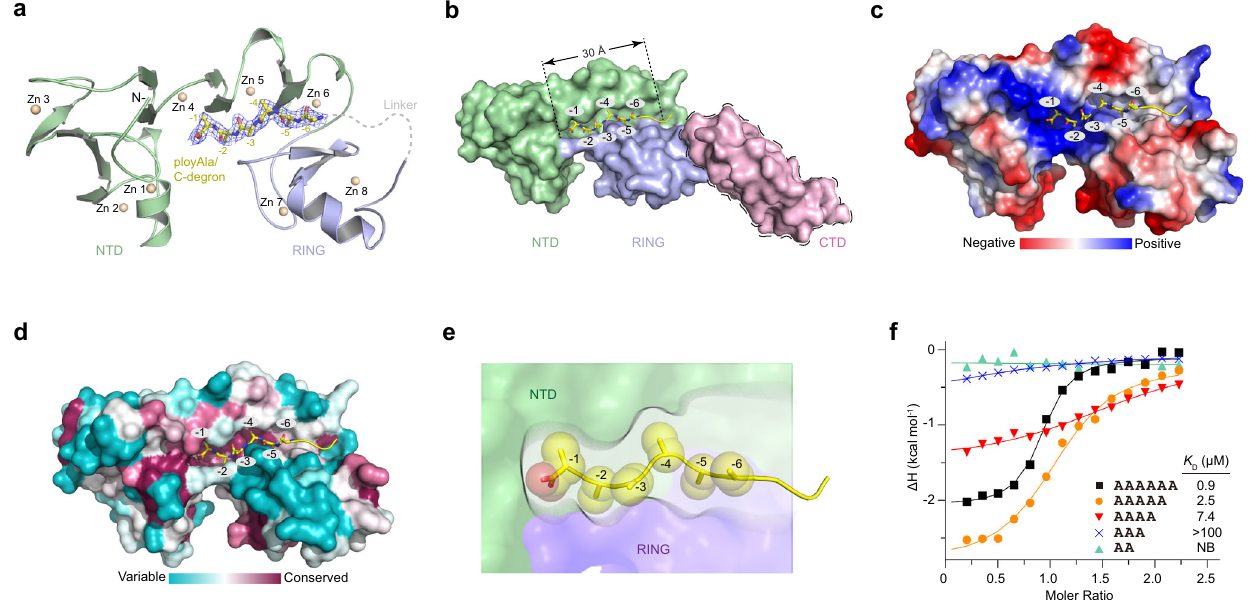
Fig.2|OverallstructureofPirh2boundtotheAla6/C-degron.a Ribbondiagram ofPirh2incomplexwiththeAla6/C-degron.NTDandRINGsubdomainsarecolored with palegreen and lightblue, respectively. Ala6/C-degron is colored with yellow. 2Fo – Fcelectron density mapof the six-Alais shown inblue and contoured to1.0 σ . Eight zinc ions are shown as lightorange spheres. b The surface view of Pirh2 (NTD+RING)incomplexwiththeAla6/C-degron.The locationof CTDispredicted by AlphaFold v2.0 (https://www.alphafold.ebi.ac.uk/). NTD, RING and CTD (sur- rounded by dotted line) subdomains are colored with palegreen, lightblue and lightpink. Ala6/C-degron is colored with yellow. c The electrostatic potential sur- face of the Ala6/C-degron-binding pocket in Pirh2 (red, negative; blue, positive).